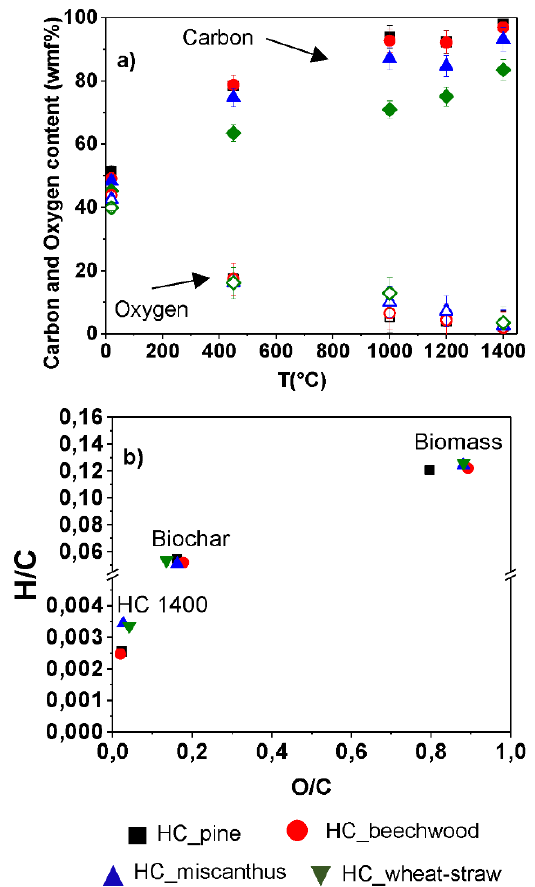
Figure 2. ( a ) Evolution of carbon and oxygen content for all the biomass-derived materials. All the percentages are in a weight moisture free basis (%wmf). ( b )Van Krevelen diagram for all the biomass-derived materials.